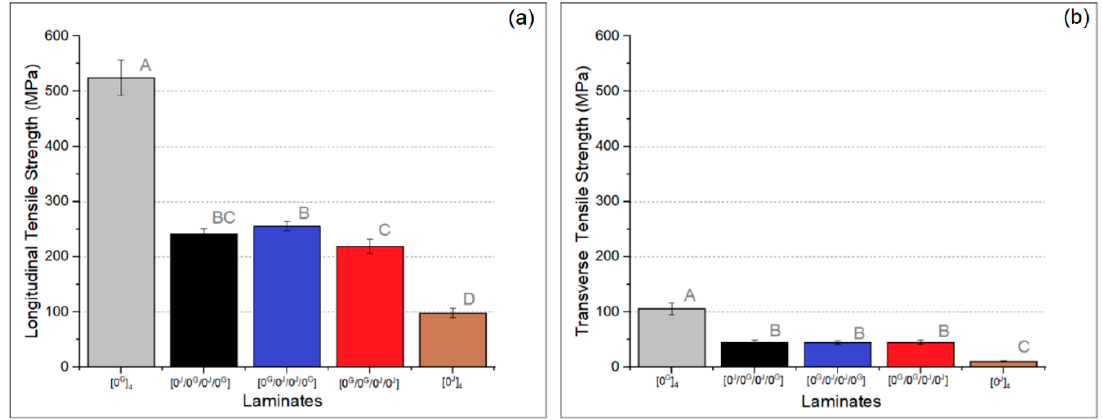
Figure 7. Longitudinal ( a ) and transverse ( b ) tensile strength of the laminates (letters represent the results of the Tukey’s test).